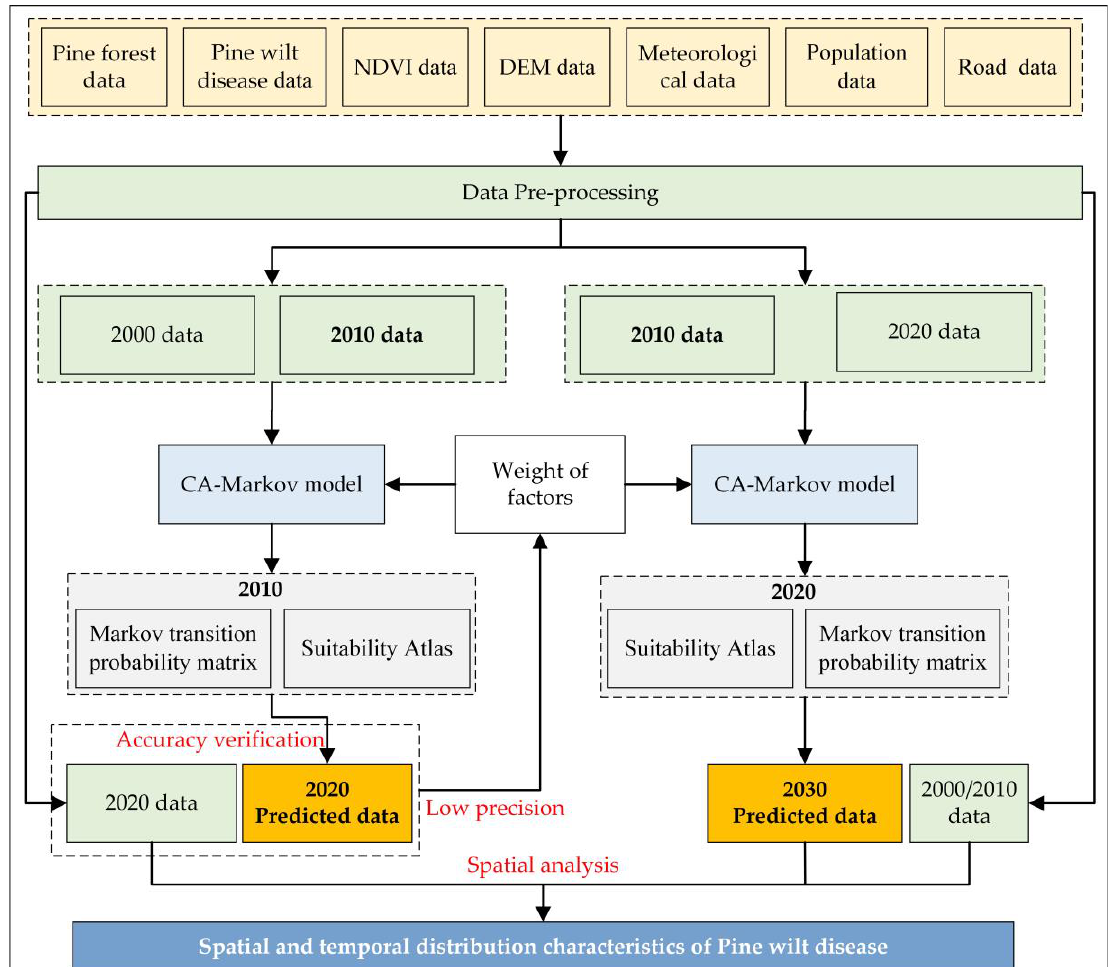
Figure 3. The technical framework of the proposed method.